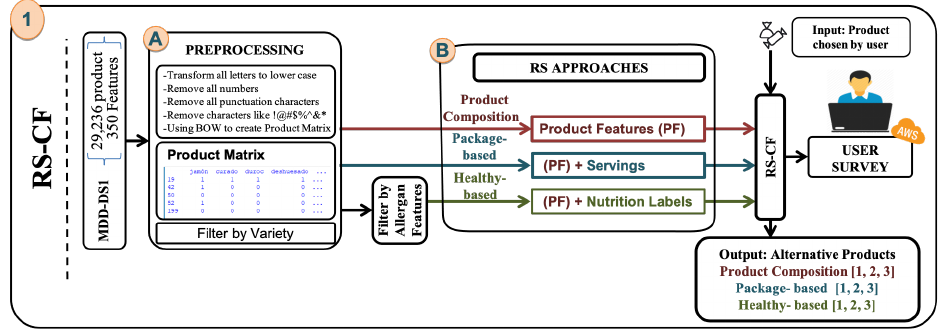
Figure 3. The modeling methodology for